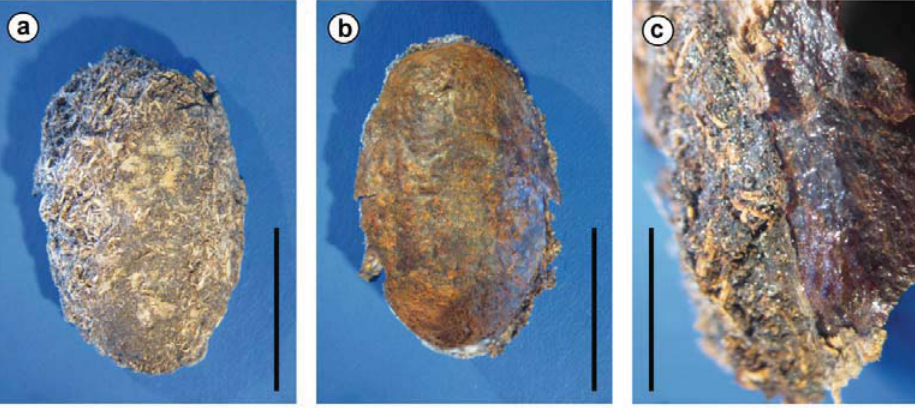
cocoon. (c) Wall of the cocoon, revealing its two-layered nature. Under an outer layer, to which substrate particles adhere (left, partly delaminating), there is an irregular, but smooth (shining) inner layer made up of amber-colored material (right). Scale bars: (a), (b) 1 cm, (c) 4